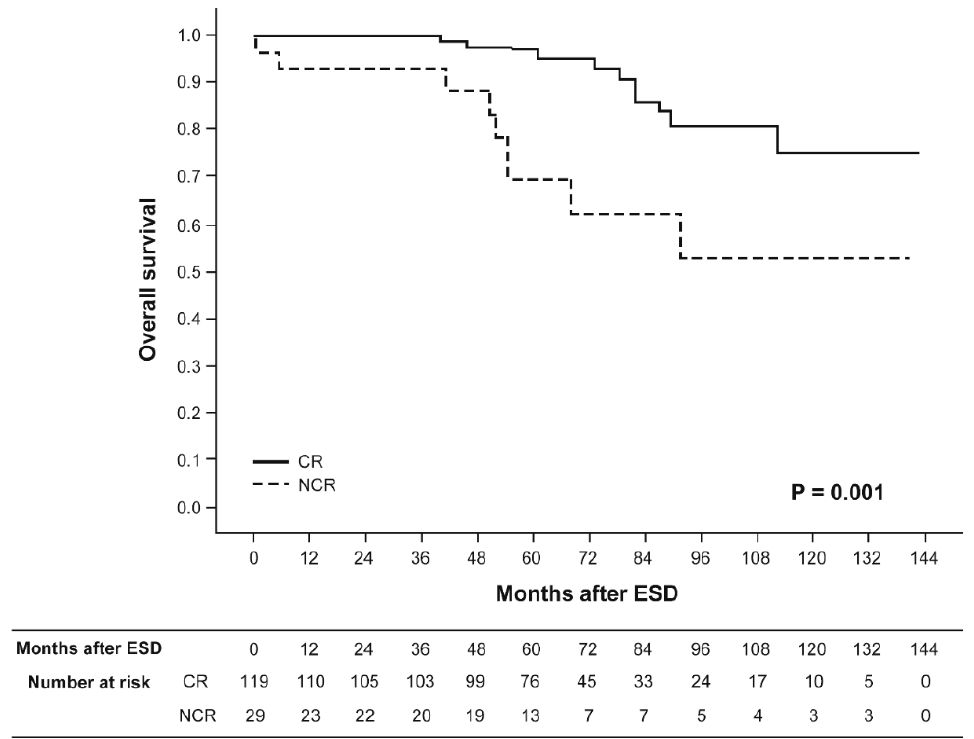
Figure 2. Kaplan–Meier overall survival curves for patients with differentiated-type-predominant early gastric cancer with histological heterogeneity undergoing endoscopic submucosal dissection. Solid line, patients treated with curative endoscopic resection (CR). Dotted line, patients undergoing non-curative endoscopic resection (NCR).